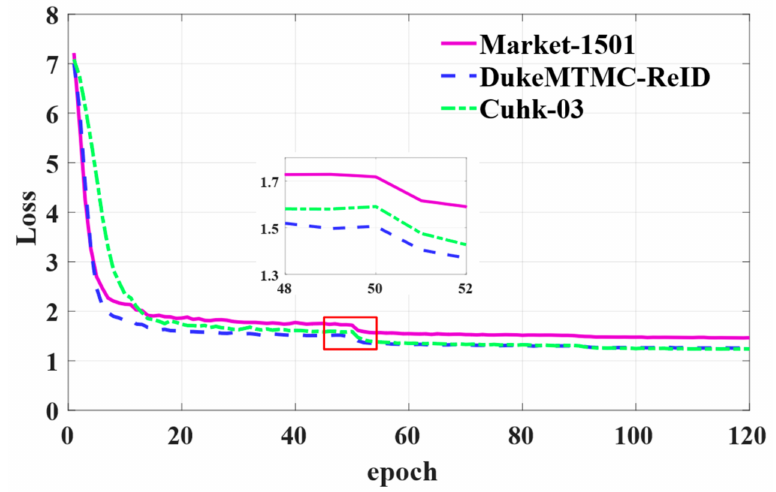
Figure 13. The loss curves of DBA-Net on three